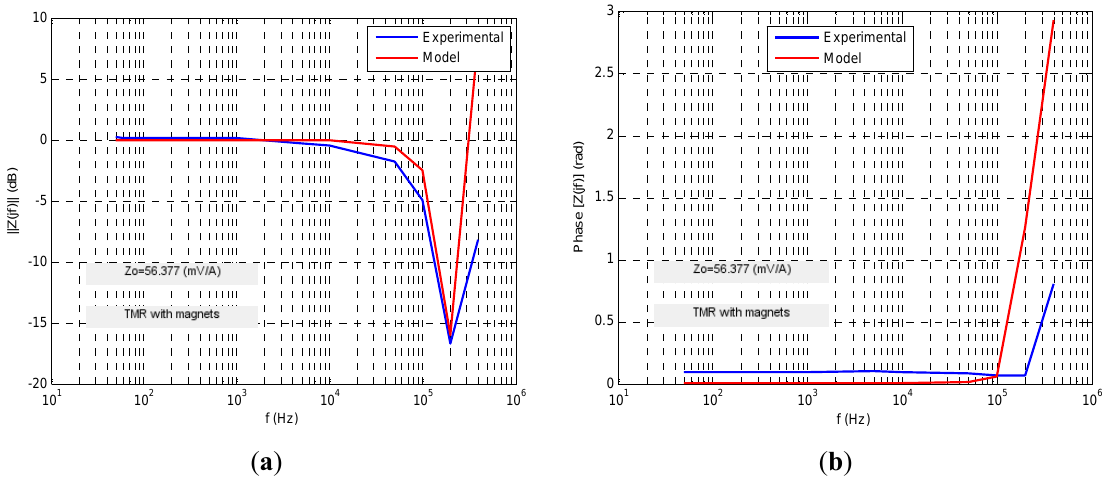
Figure 14. TMR sensor with internal magnetization ac large-signal fractional